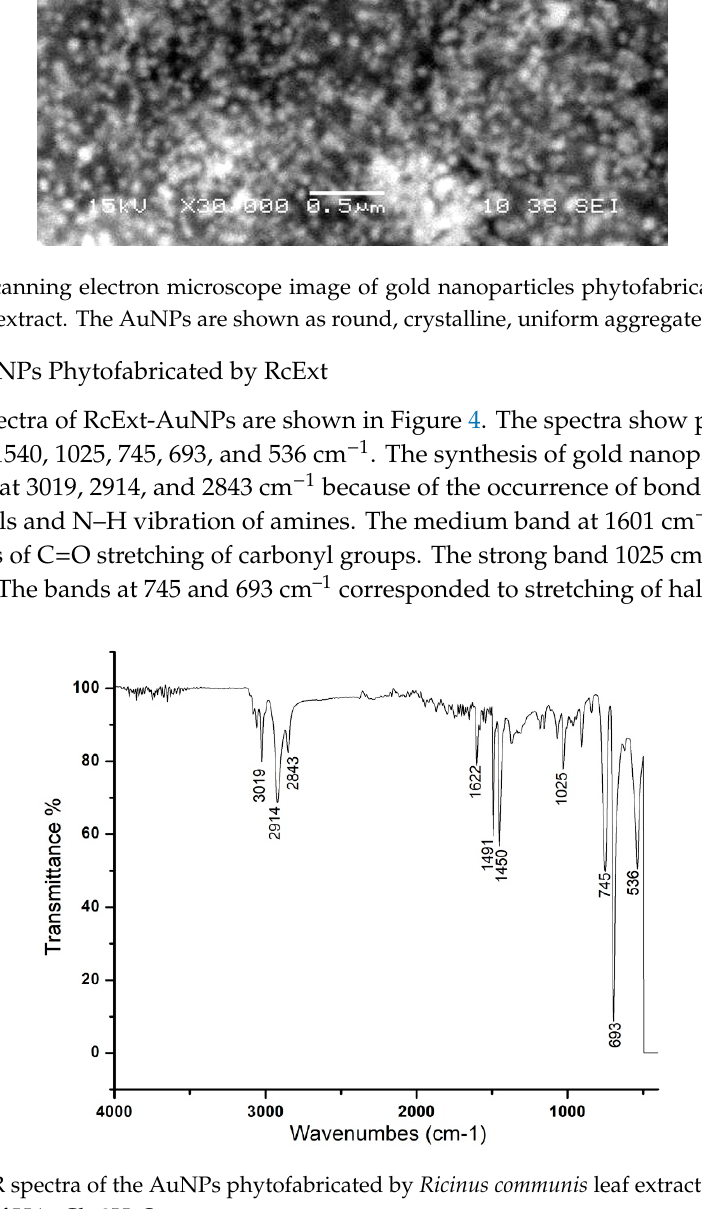
Figure 4. FT-IR spectra of the AuNPs phytofabricated by Ricinus communis leaf extract reduced with 1 mM solution of HAuCl 4 ·3H 2 O.